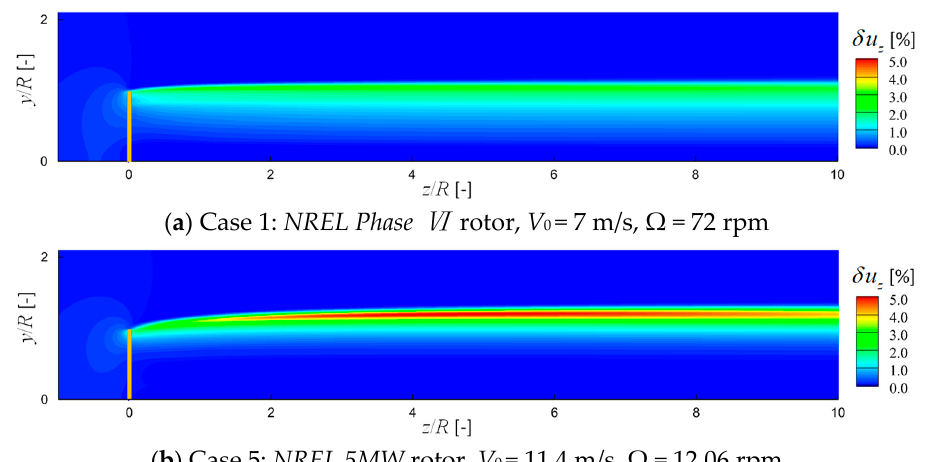
Figure 9. Contours of the axial velocity difference between the results of the new and the Glauert-C tip loss corrections.